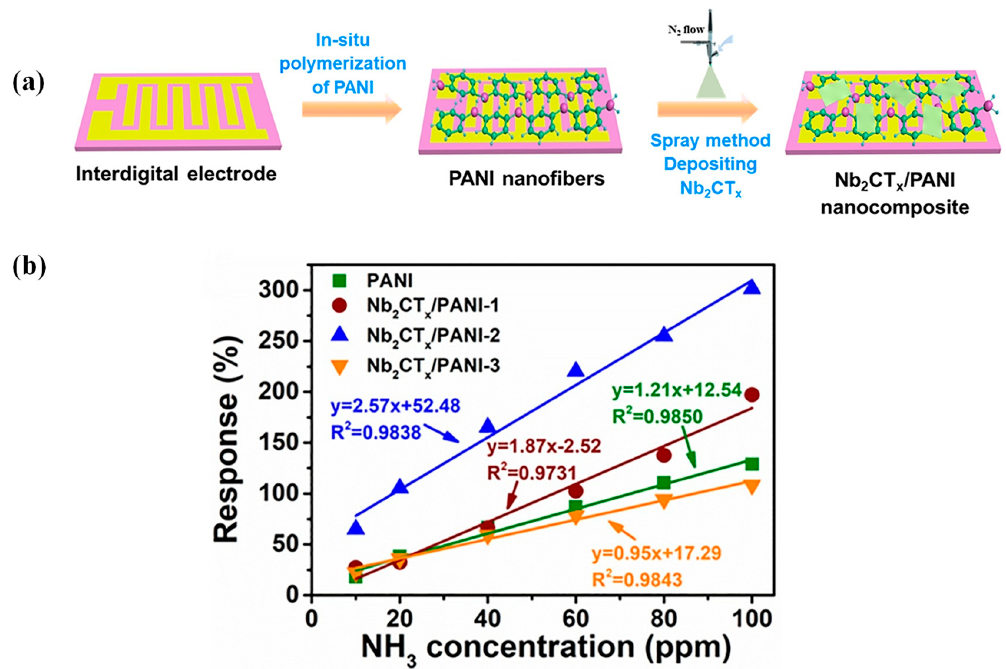
Figure 14. ( a ) Schematic illustration of fabrication process of the Nb 2 CT x /PANI sensor, ( b ) Response–concentration fitting curves of the PANI, Nb 2 CT x /PANI-1, Nb 2 CT x /PANI-2 and Nb 2 CT x /PANI-3 sensors toward 10–100 ppm NH 3 . [28] Copyright Elsevier, 2020.